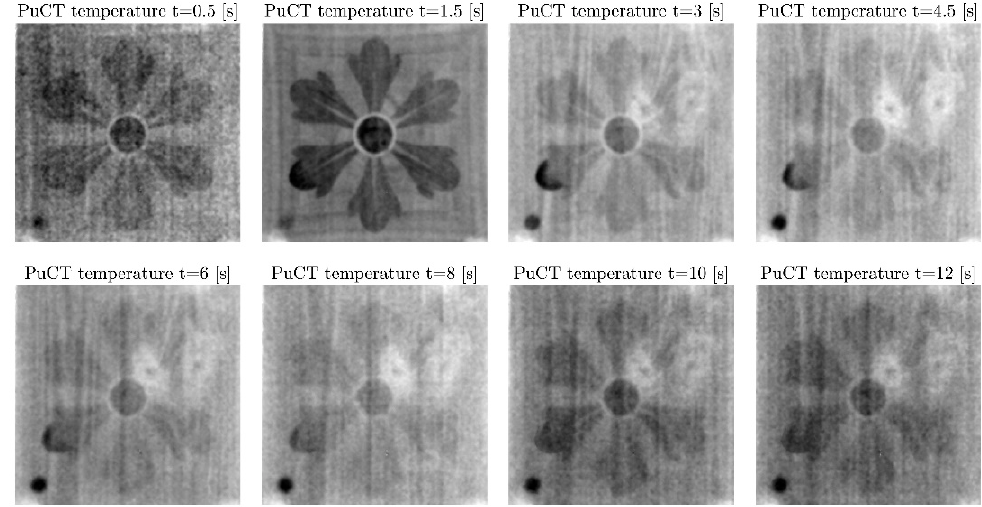
Figure 6. Selected thermograms obtained after PuCT applied to experimental data collected with FLIR T660, i.e., setup (a).